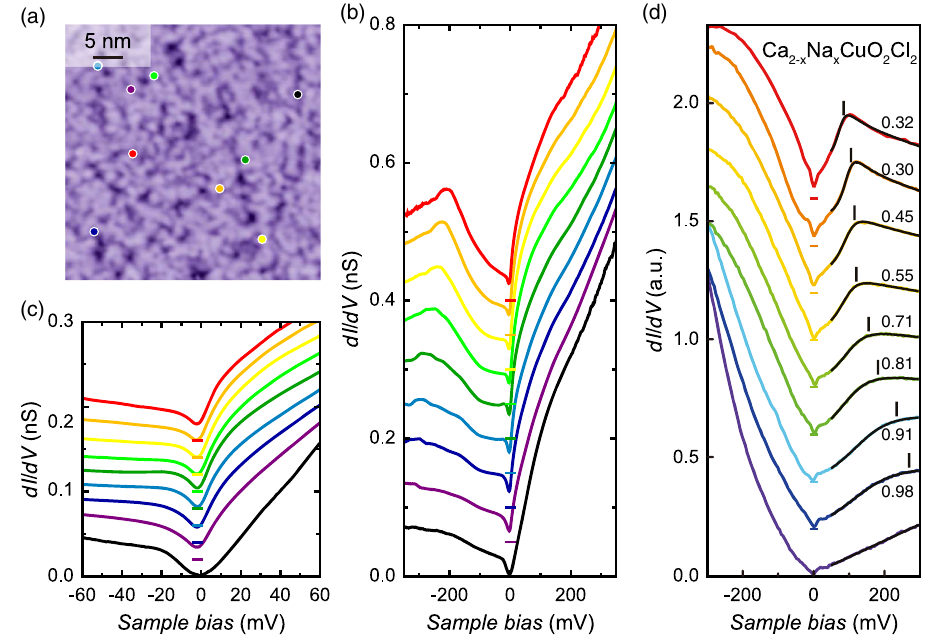
FIG. 5. (a) STM topography on the strongly insulating x ¼ 0 . 30 sample acquired with V ¼ 100 mV and I ¼ 10 pA. (b) Typical dI=dV curves (shifted vertically) taken at locations marked by the colored dots in (a), set up accordingly as Fig. 3(b) with V ¼ 400 mV and I ¼ 180 pA. (c) Same as (b) but zoom-in on the low-energy range near E F , which reveals a V-shaped gap. (d) dI=dV spectra taken at various locations in lightly hole-doped Mott insulator Ca 2 − x Na x Cu 2 OCl 2 ( 0 . 06 ≤ x ≤ 0 . 12 ). Adapted by permission from Y. Kohsaka, Nat. Phys. 8 , 534 (2012). Copyright 2012, Macmillan Publishers Ltd.